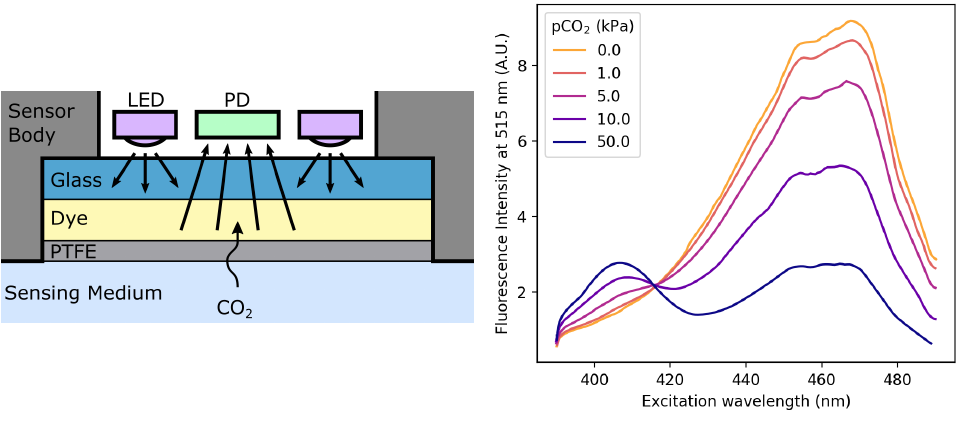
Figure 7. ( Left ) outline schematic of a typical dye-based CO 2 sensor. The LEDs illuminate a pH- sensitive dye, either dissolved in an aqueous solution or a polymer, through a layer of transparent substrate—here a glass slide. The dye is protected from ionic contamination by a PTFE, gas-permeable, ion-impermeable membrane. The LEDs and photodiode may additionally be covered by excitation or emission filters in case of fluorescence measurement. ( Right ) the fluorescence excitation spectra of 1 mM HPTS in carbonated distilled water equilibrated with different pCO 2 values. Data source: Uttamlal et al.